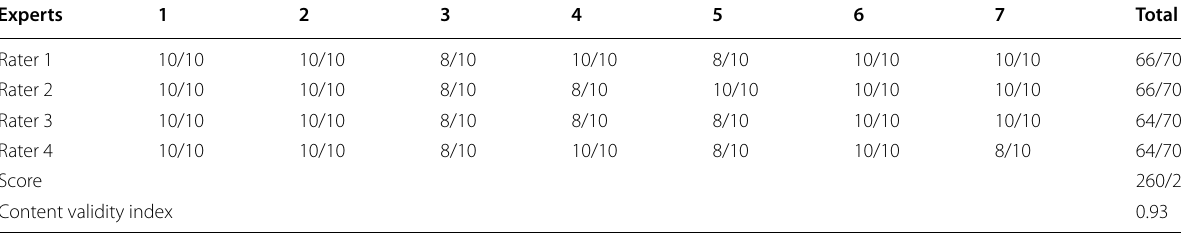
Table 3 Content validity index of Malay version of sQOD-NS